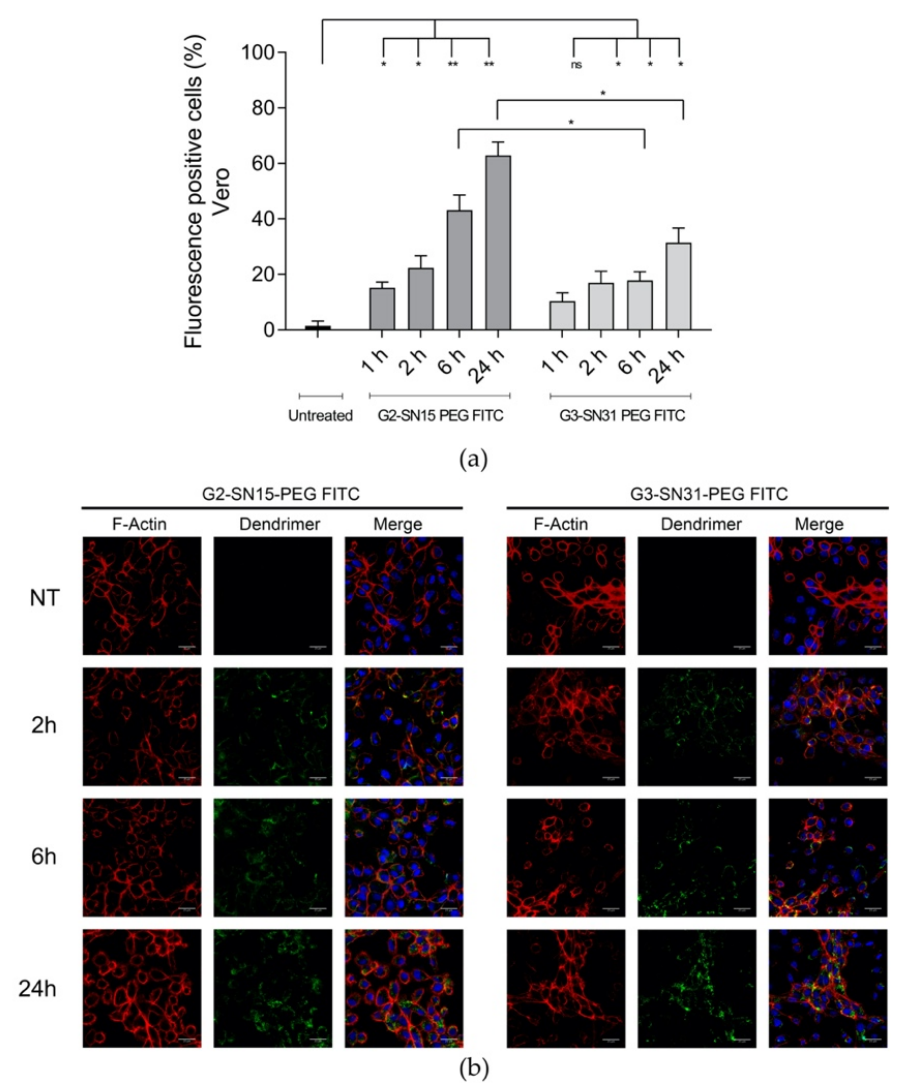
Figure 2. Internalization study of cationic dendrimers into Vero cells. ( a ) Percentage of FITC-positive cells observed by flow cytometry 1 h, 2 h, 6 h and 24 h post-treatment. Data are represented as mean ± SD of two individual experiments. ( b ) Representative confocal images of cells incubated with 1 µM G2-SN15-PEG FITC and 0.5 µM G3-SN31-PEG FITC dendrimers (green) for 2 h, 6 h or 24 h. Phalloidin was used to mark actin filaments (red) and DAPI for nucleus (blue). Scale bars indicate a length of 25 µm. (* p < 0.05; ** p < 0.01; ns: non-significant). DAPI: 4 ′ ,6-diamidino-2-phenylindole dihydrochloride.